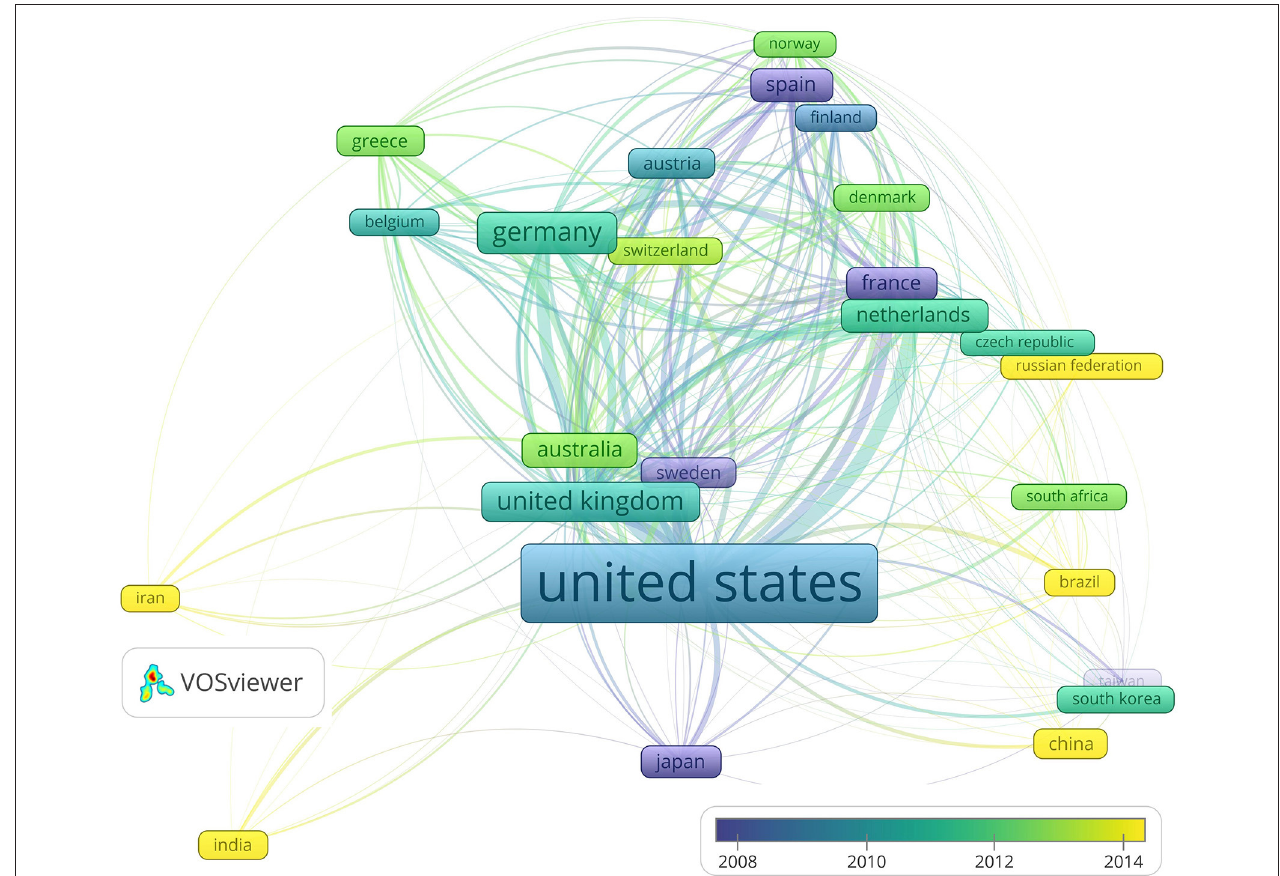
FIGURE 3 | Country Co-operation network based on Co-authorships between 30 most productive countries.